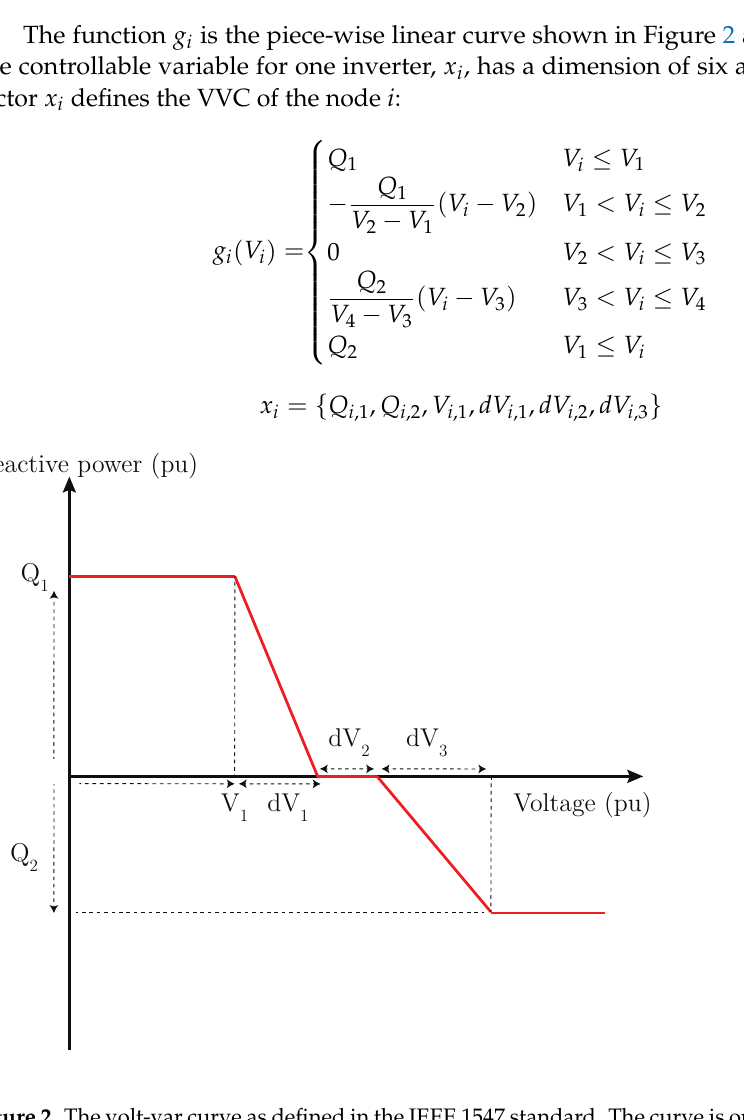
Figure 2. The volt-var curve as defined in the IEEE 1547 standard. The curve is optimized by changing the six variables shown on this plot. The x -values of the VVC is given by